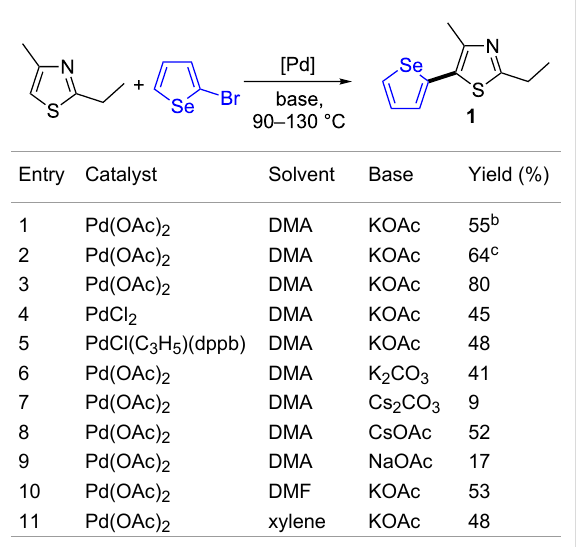
Table 1: Influence of the reaction conditions for the coupling of 2-ethyl- 4-methylthiazole with 2-bromoselenophene.